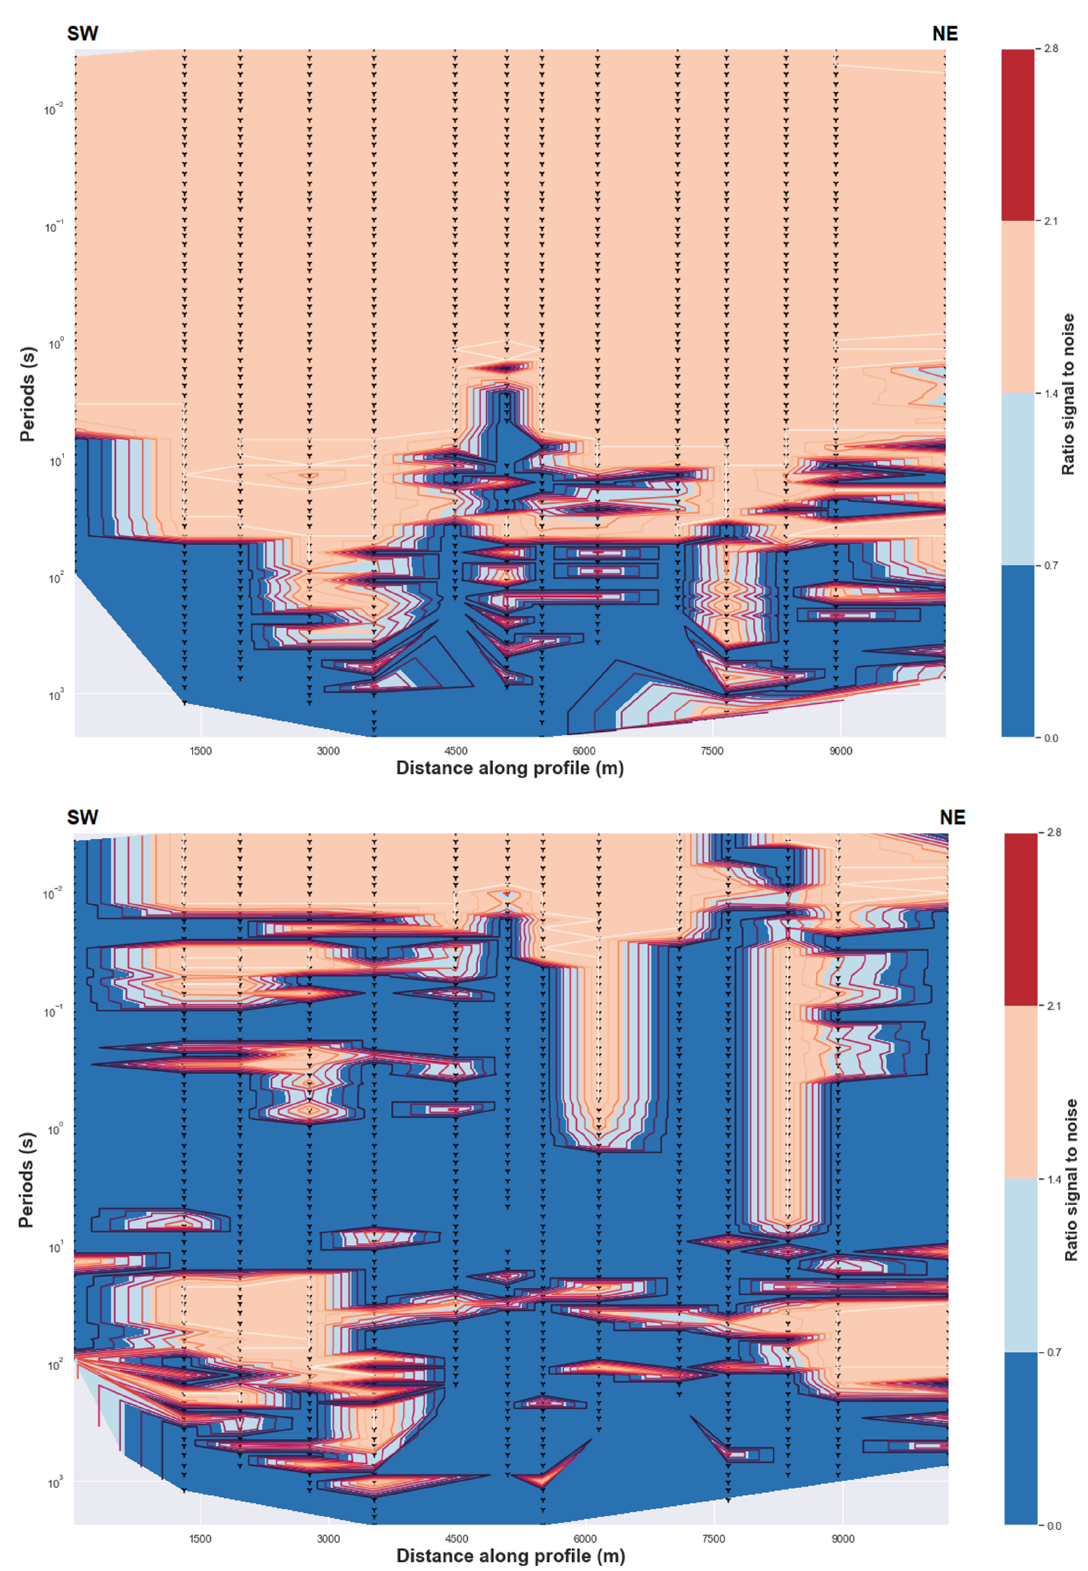
Figure A1. ( Above ) Uncertainty of the impedance estimates. ( Below ) Uncertainty of the tipper esti- mates.